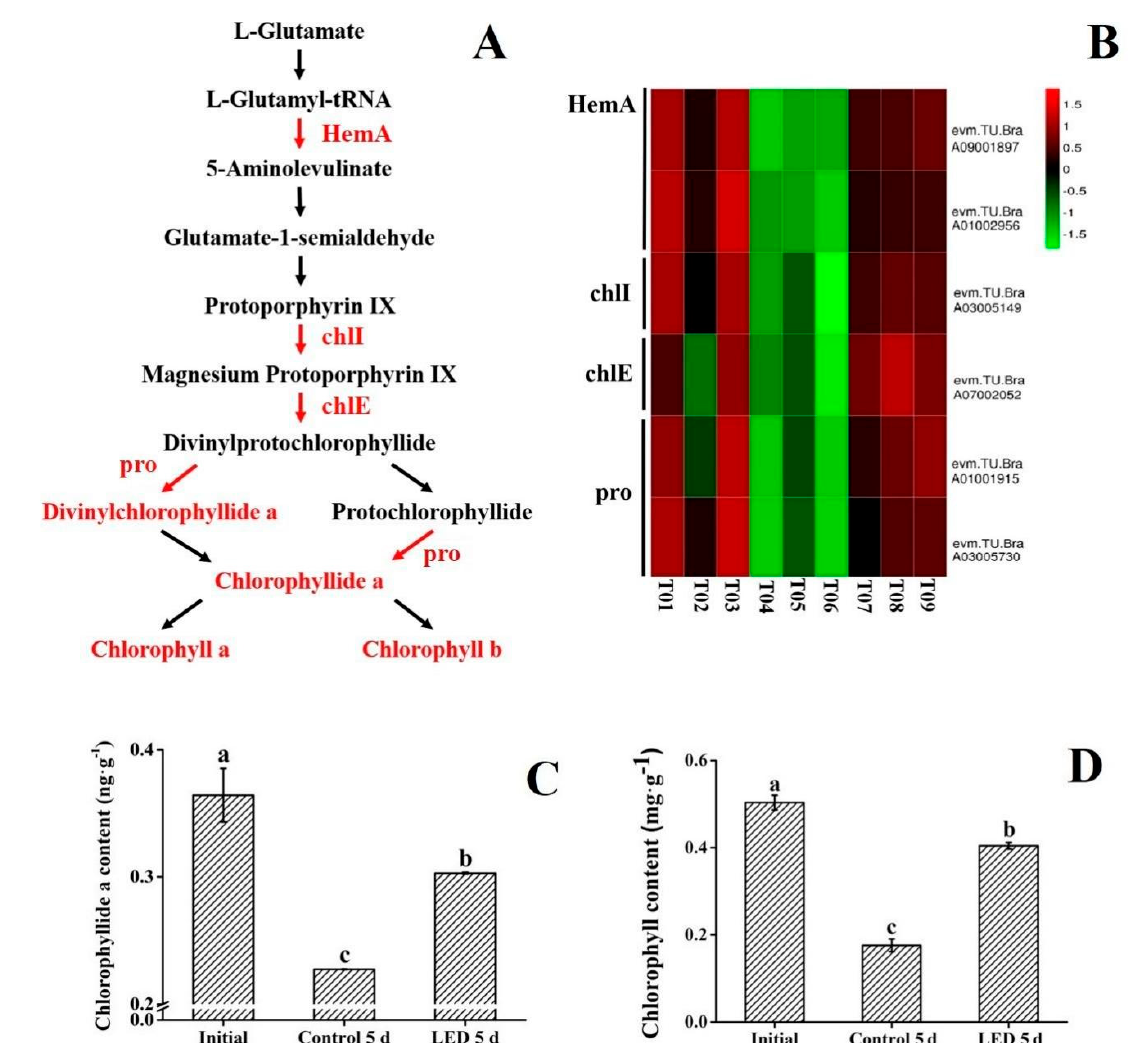
Figure 3. The e ff ect of LED irradiation on the expression of genes involved in the chlorophyll synthesis and chlorophyll and chlorophyllide a content in pak-choi. ( A ) Metabolites or genes expressed at a higher level in the LED treatment group, relative to the dark-stored (control) treatment group, are illustrated in red. Metabolites or genes expressed at a lower level in the LED treatment group, relative to the dark-stored (control) treatment group, are illustrated in green. ( B ) Expression pattern of genes involved in the porphyrin and chlorophyll metabolism pathways in response to LED irradiation. Six DEGs (FC ≥ 2; FDR ≤ 0.01) associated with photosynthesis were identified. Log2 based FPKM values were used to create the heat map. The scale represents the relative signal intensity of FPKM values (T01, T02, T03: initial; T04, T05, T06: dark-stored control 5d; T07, T08, T09: LED 5 d). ( C , D ) Levels of chlorophyllide a ( C ) and chlorophyll ( D ) in the three treatment groups (initial, dark-stored control 5d, and LED treatment 5d). Vertical bars represent the standard error of the mean ( n = 3). Means denoted by the same letter do not di ff er significantly at p < 0.05 as determined by LSD’s multiple range test.